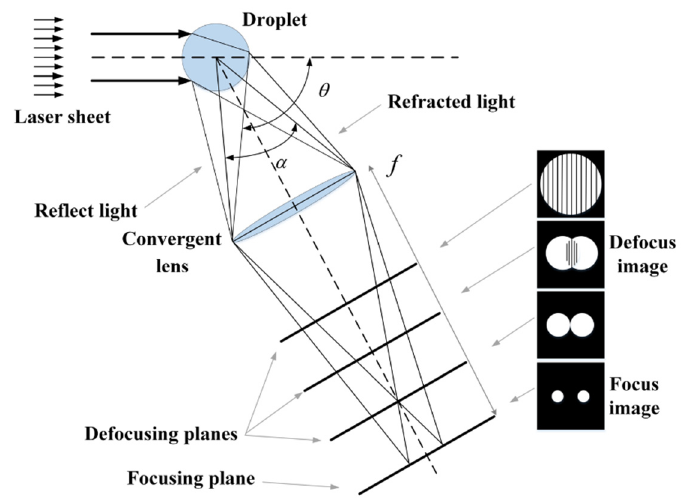
Figure 5. Scattered light imaging of single droplet.